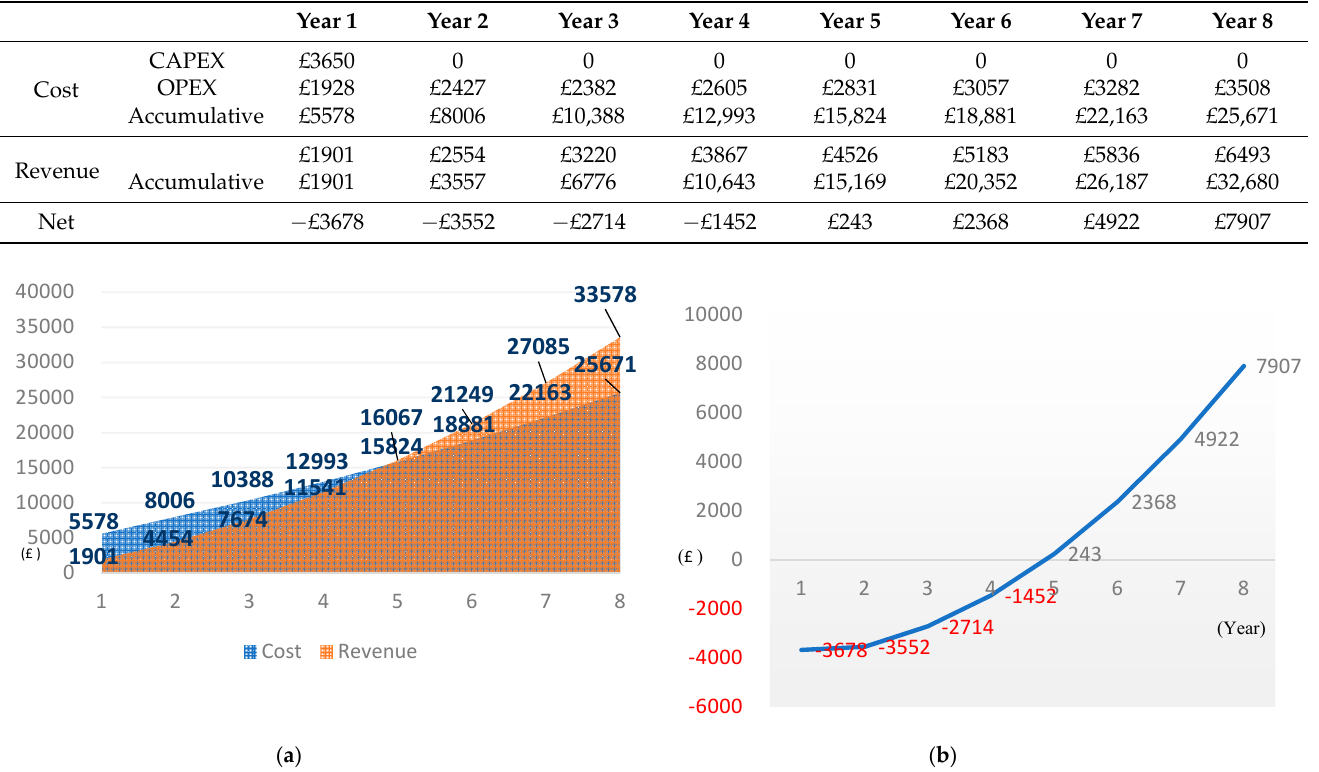
Table 20. Cost and revenue of PCS in County Durham (one charger and higher price) in GBP.